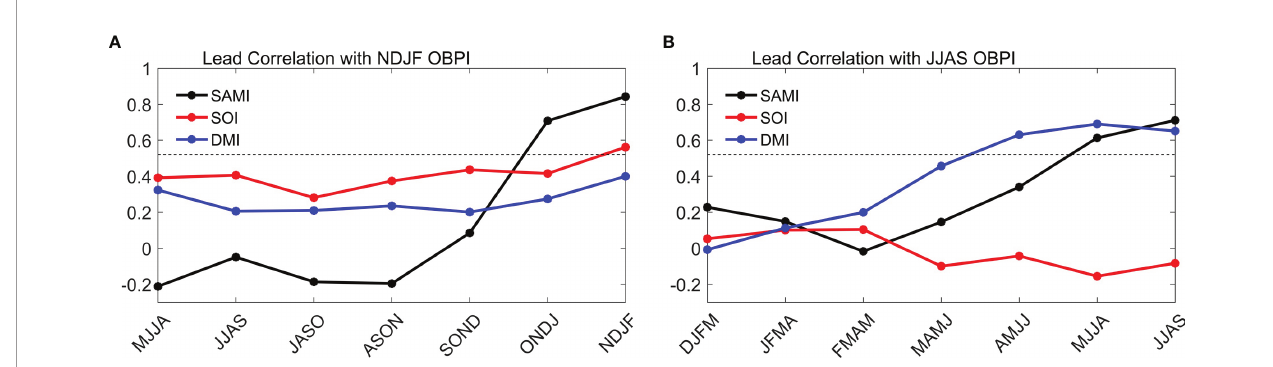
FIGURE 6 | Lead correlation coef fi cients of the (A) NDJF-averaged GRACE OBPI and (B) JJAS-averaged GRACE OBPI with the 4-month averaged SAMI, SOI and DMI. The horizontal dashed line shows the 95% signi fi